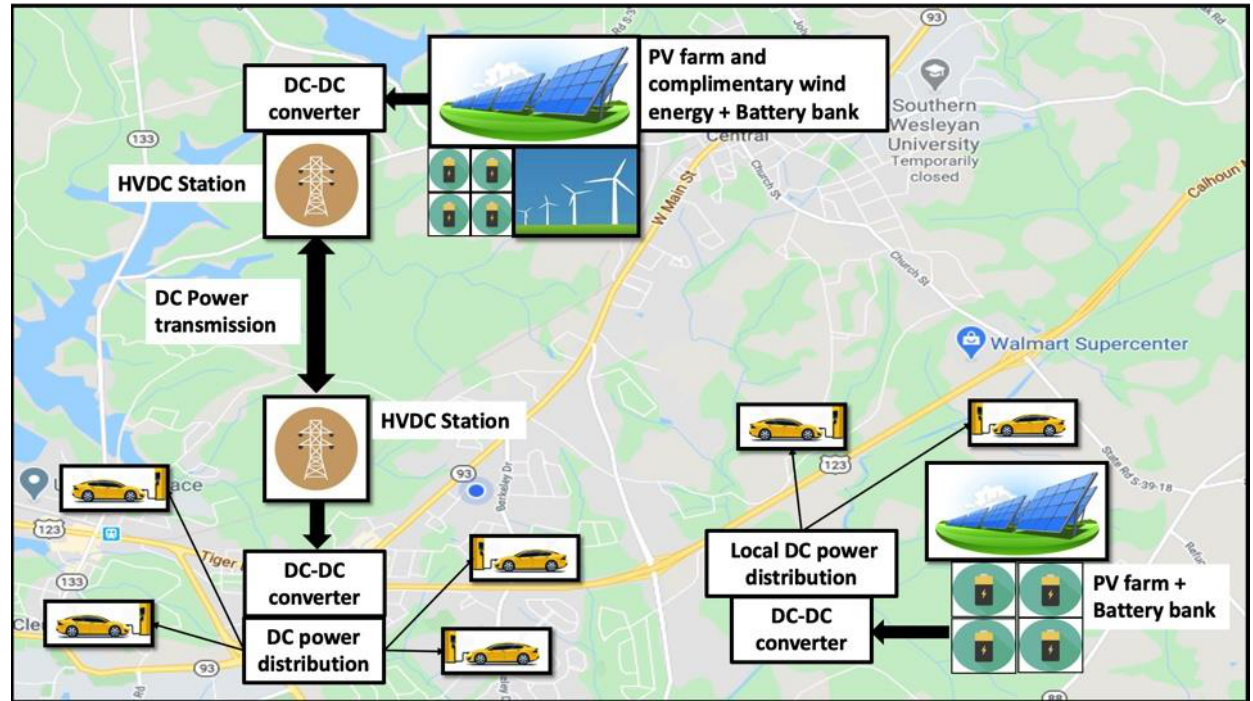
Figure 4. Concept of complete DC EV charging infrastructure.